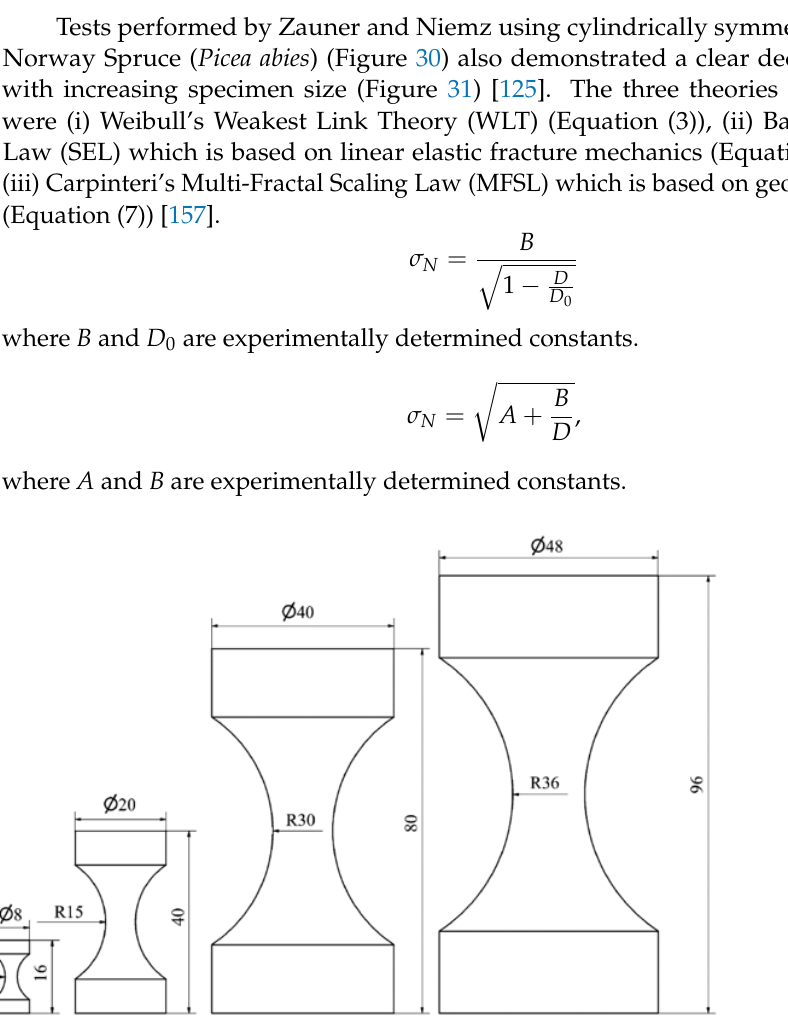
Figure 30. Cylindrically symmetric compression specimens used to investigate size effects in com- pression testing of Norway Spruce. Dimensions given in mm. From [125].